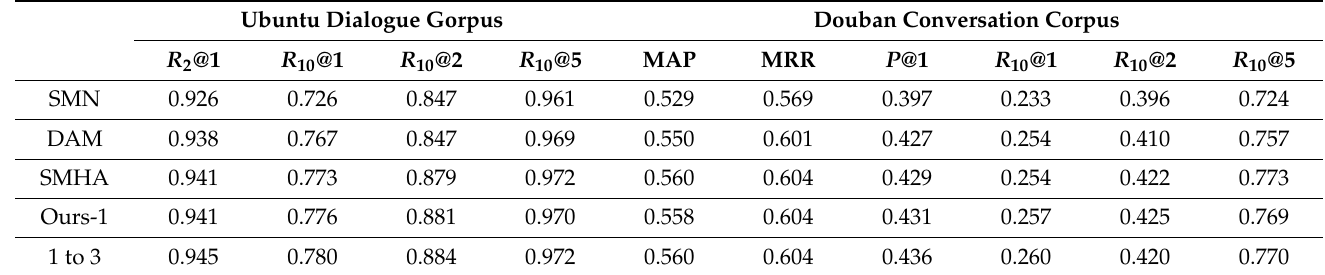
Table 7. The results of the comparison experiment for the two proposed